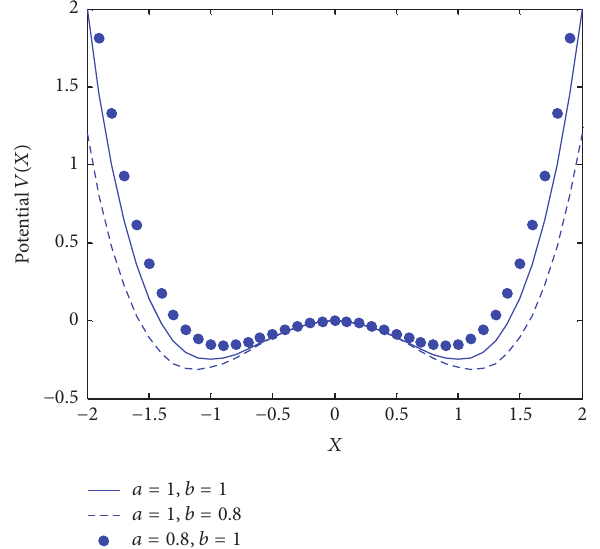
Figure 1: The potential function in different cases.